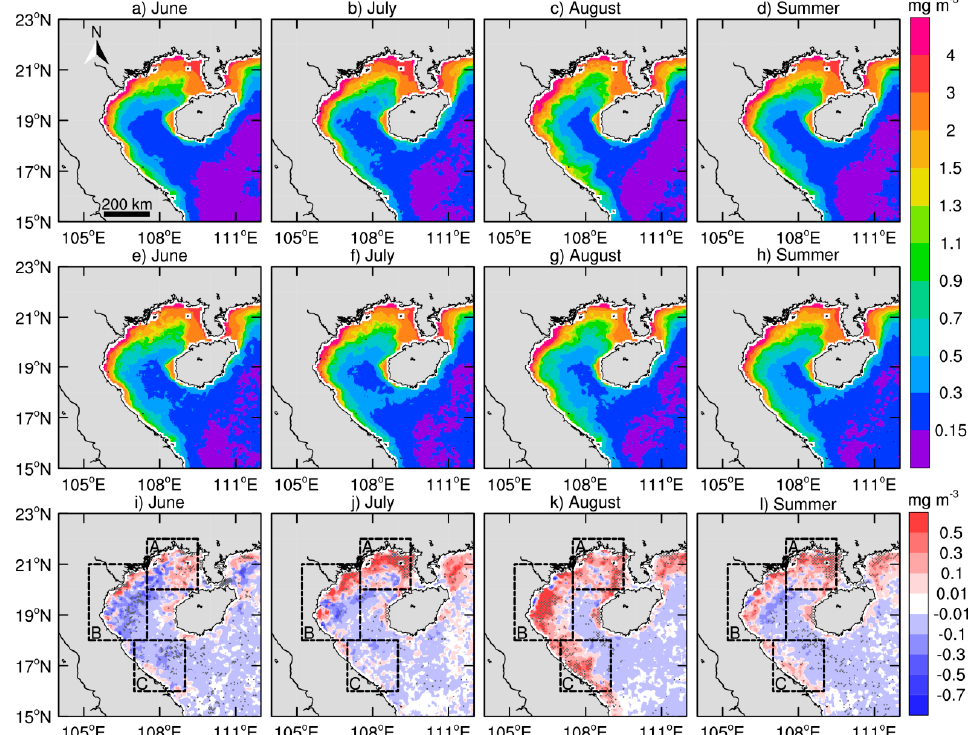
Figure 4. Average distribution of chl-a concentrations on LLJ days in ( a ) June, ( b ) July, ( c ) August, and ( d ) summer, on non-LLJ days in ( e ) June, ( f ) July, ( g ) August, and ( h ) summer and the difference between LLJ and non-LLJ days in ( i ) June, ( j ) July, ( k ) August, and ( l ) summer (the gray dots cover areas with significant differences).